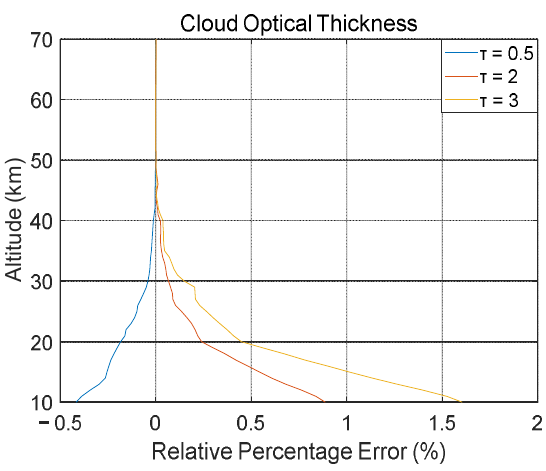
Figure 9. Relative errors of different cloud optical thicknesses.